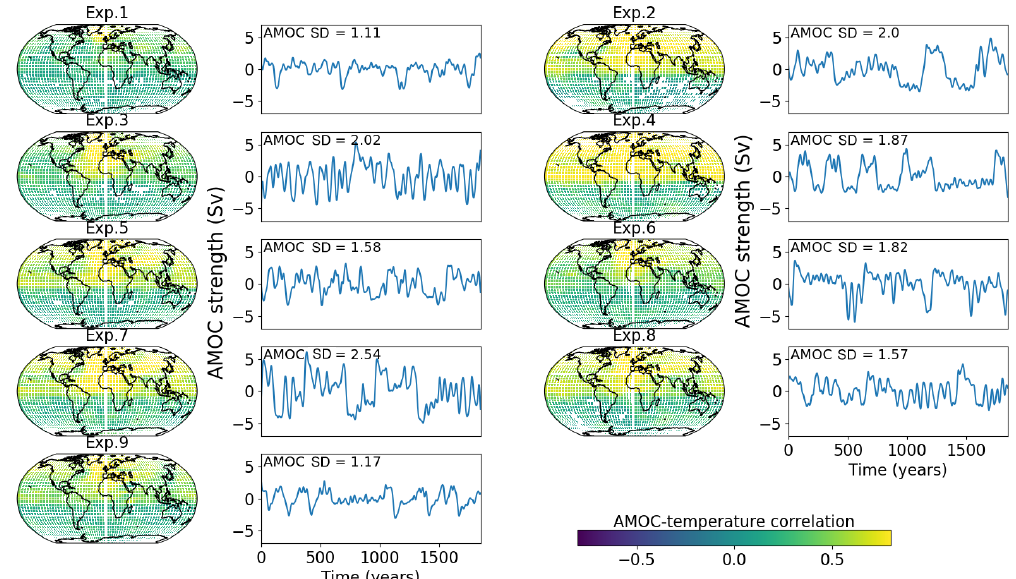
Figure 3. For the different ensemble members, the correlation factors (left-hand maps) between grid-based temperature time series and the AMOC anomalies (maximum overturning stream function in the North Atlantic below 500m) are shown. These are lagged correlations on a grid cell basis. Also shown are the time series of the AMOC (right-hand line plots with units in Sv) with the AMOC standard deviation shown in the top